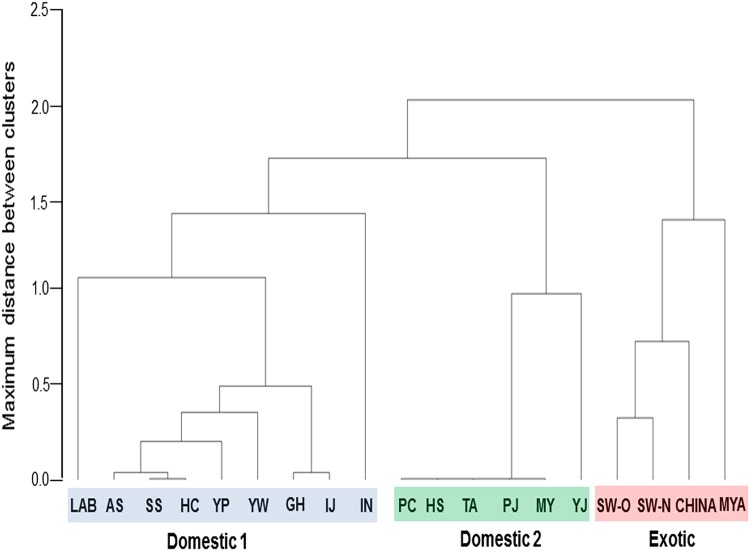
Genetic distance analysis among 19 local populations of M. vitrata using RAPD.Hierarchical clustering was performed using band polymorphism obtained from RAPD 8041 primer. These local populations included Myanmar (‘MYA’), China (‘CHINA’), Suwon 2018 (‘SW-N’), Suwon 2017 (‘SW-O’), Ganghwa (‘GH’), Pyungchang (‘PC’), Hoeungsung (‘HS’), Seosan (‘SS’), Ansan (‘AS’), Yeongju (‘YJ’), Paju (‘PJ’), Iksan (‘IS’), Miryang (‘MY’), Taean (‘TA’), Youngwol (‘YW’), Yangpyeong (‘YP’), Inje (‘IJ’), Hongchun (‘HC’), and a laboratory strain (‘LAB’). Local coordinates are 37°5′12.7″N 127°22′28.1″E for AS, 36°53′53.71″N 127°9′47.97″E for CA, 37°48′03.1″N 126°14′03.3″E for GH, 37°46′27″N 128°00′57″E for HC, 37°26′28″N 128°8′46″E for HS, 38°1′25″N 128°17′0″E for IJ, 35°44′29.04″N 129°2′14.28″E for KJ, 35°29′40.22″N 128°44′11.52″E for MY, 37°22′46.722″N 128°21′55.985″E for PC, 37°58′13.52″N 126°56′44.75″E for PJ, 36°45′57.22″N 126°30′11.64″E for SS, 37°15′43″N 126°59′15″E for SW, 36°40′6.47″N 126°18′4.95″E for TA, 37°6′56″N 127°23′11″E for YI, 37°33′16.81″N 127°43′03.19″E for YP, and 37°11′18″N 128°22′20″E for YW.